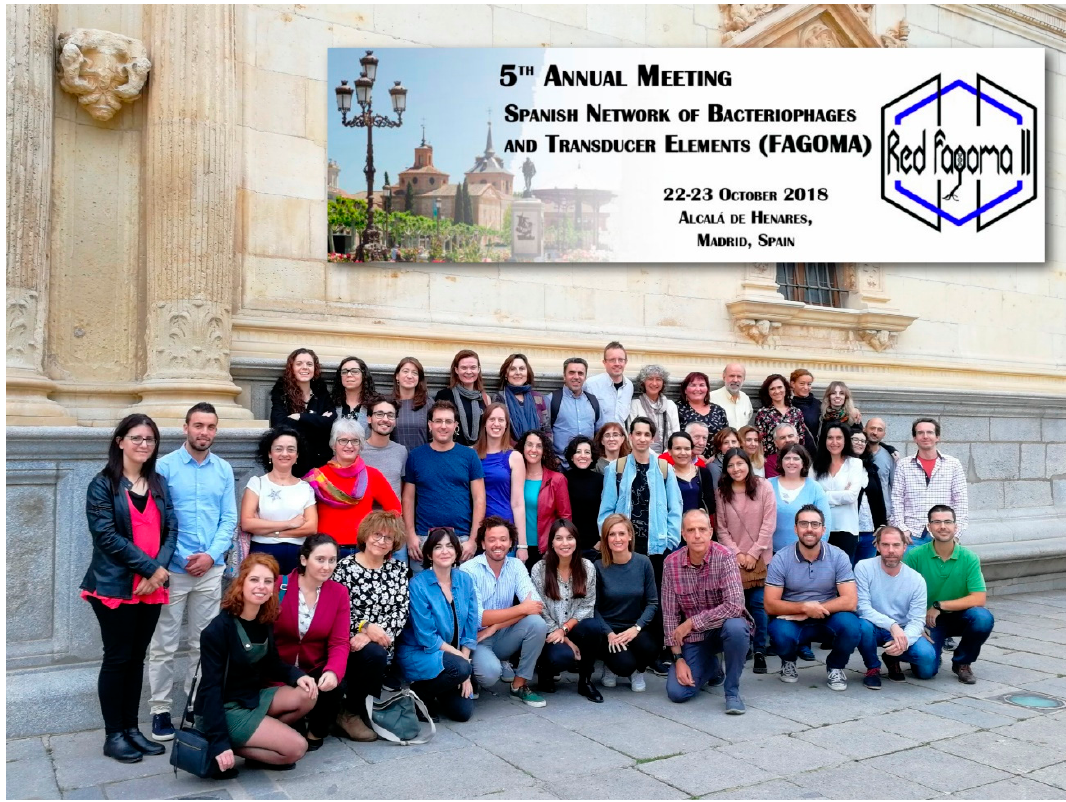
Figure 2. Participants of the V FAGOMA II meeting.